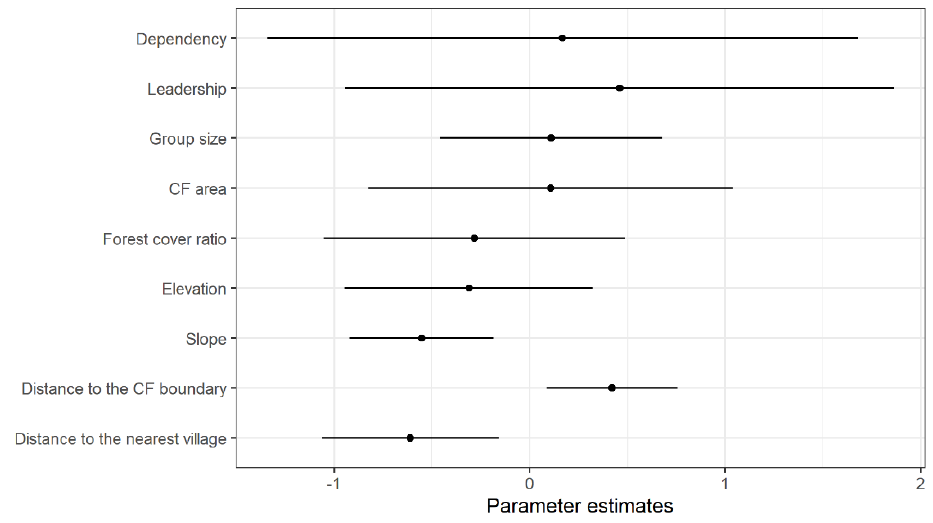
Figure 3. Parameter estimates of independent variables used for model averaging. Black dots and lines represent coefficient estimates and 95% confidence intervals, respectively.